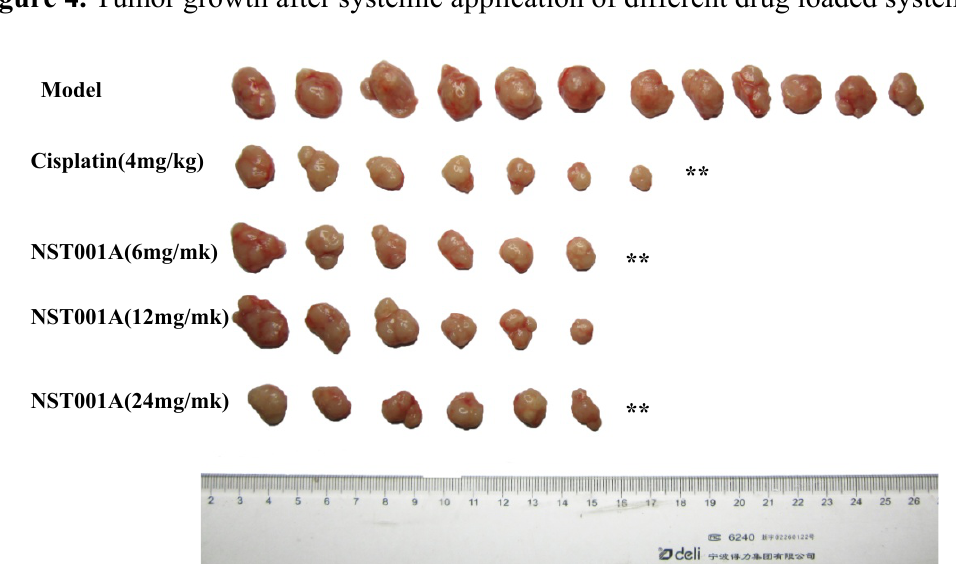
Figure 4. Tumor growth after systemic application of different drug loaded